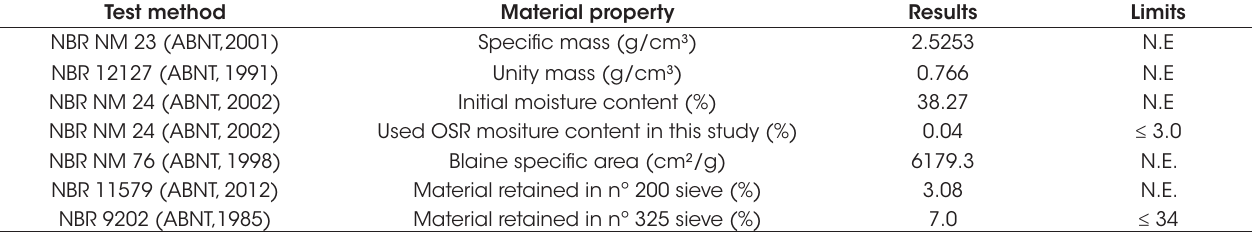
Physical characterization of OSR Test